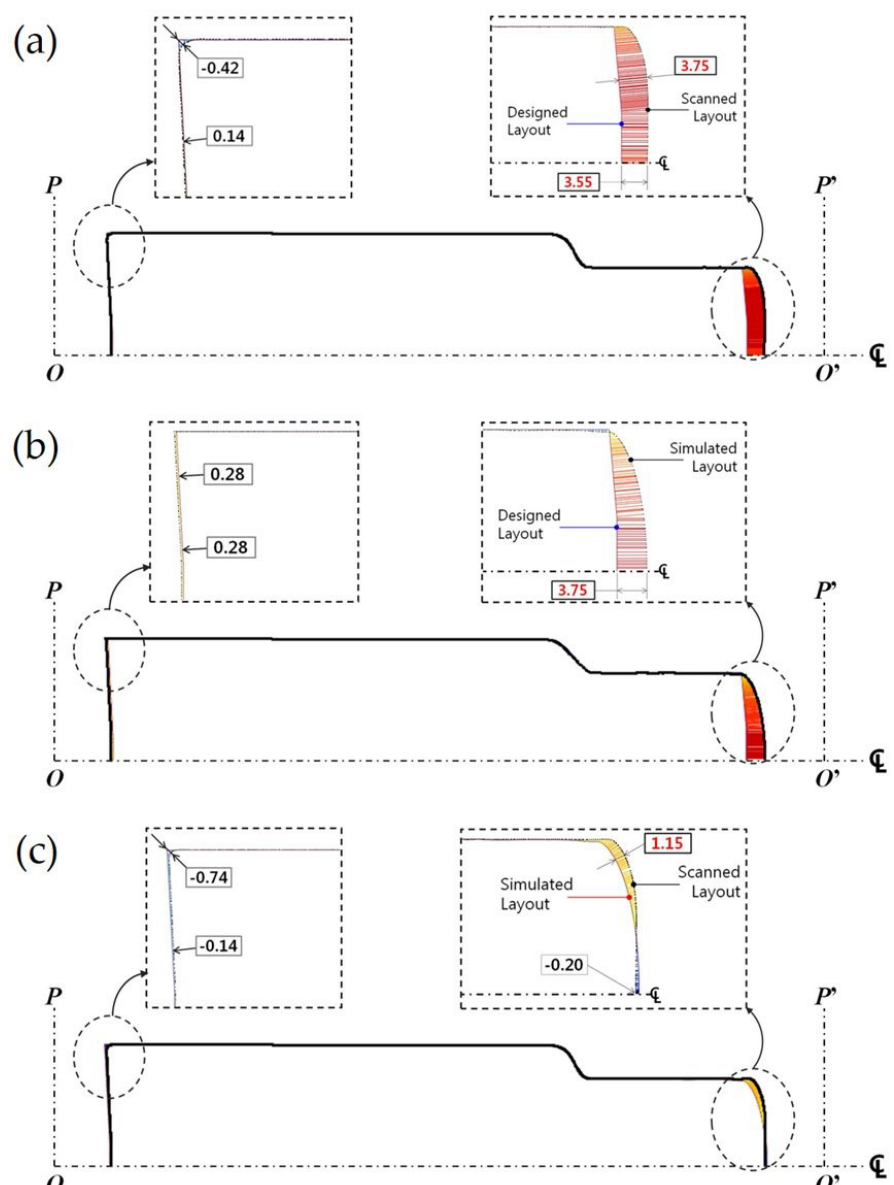
Figure 11. Dimensional suitability of forward extruded preform on OP - O’P’ cross-sectional plane (unit: mm): ( a ) Comparison of dimensional suitability between 3D scanned image and designed preform; ( b ) Comparison of dimensional suitability between simulated layout and designed preform; ( c ) Comparison of dimensional suitability between 3D scanned image and simulated layout.